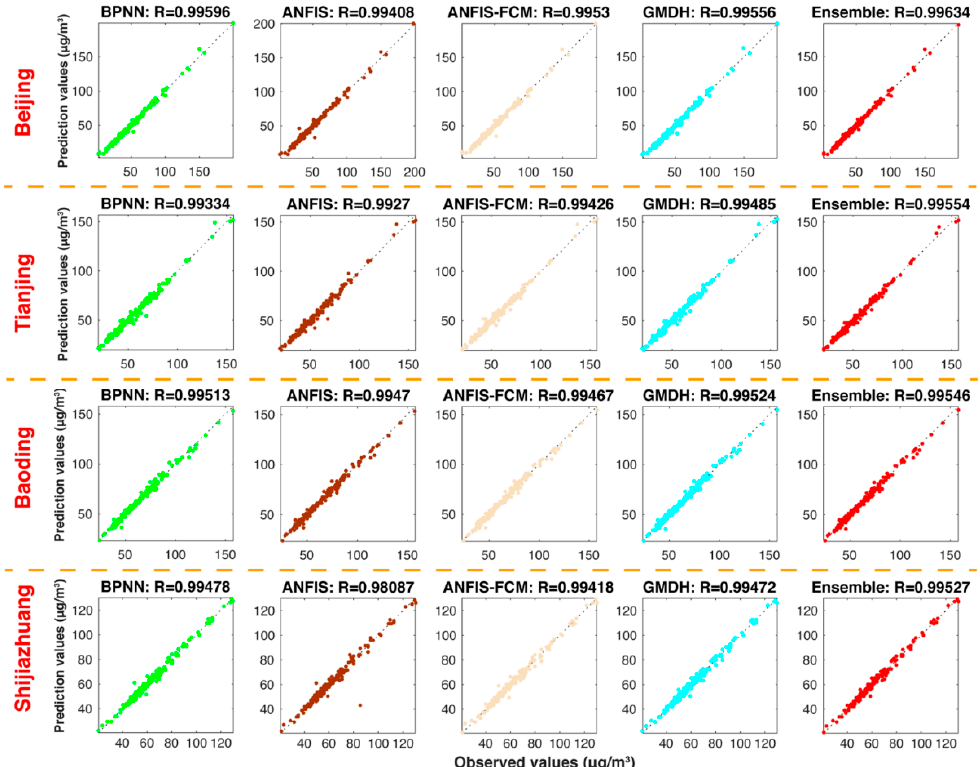
Figure 2. Forecasting results of the ensemble model and VMD-based models.